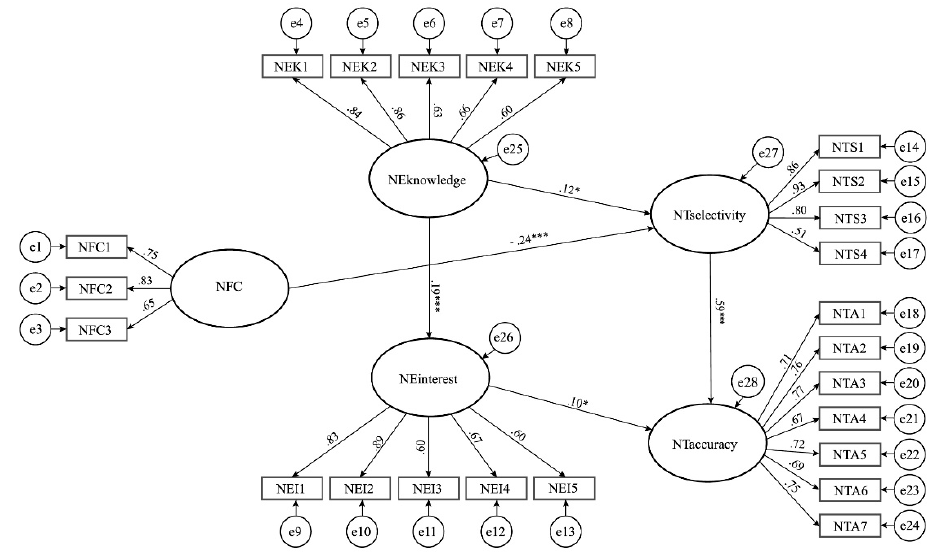
Figure 2. The final model of the relationship between NFC, news engagement, and news trust (Significance level: * p < 0.05; *** p < 0.001). (Significance level: * p < 0.05; *** p <